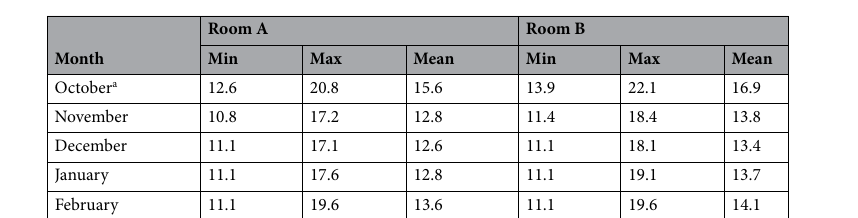
Table 3. Temperature values (°C) from ibuttons placed on the wall of temperature-controlled rooms during the study period, expressed as monthly absolute minimum, absolute maximum and means. a Including data from October 15 to